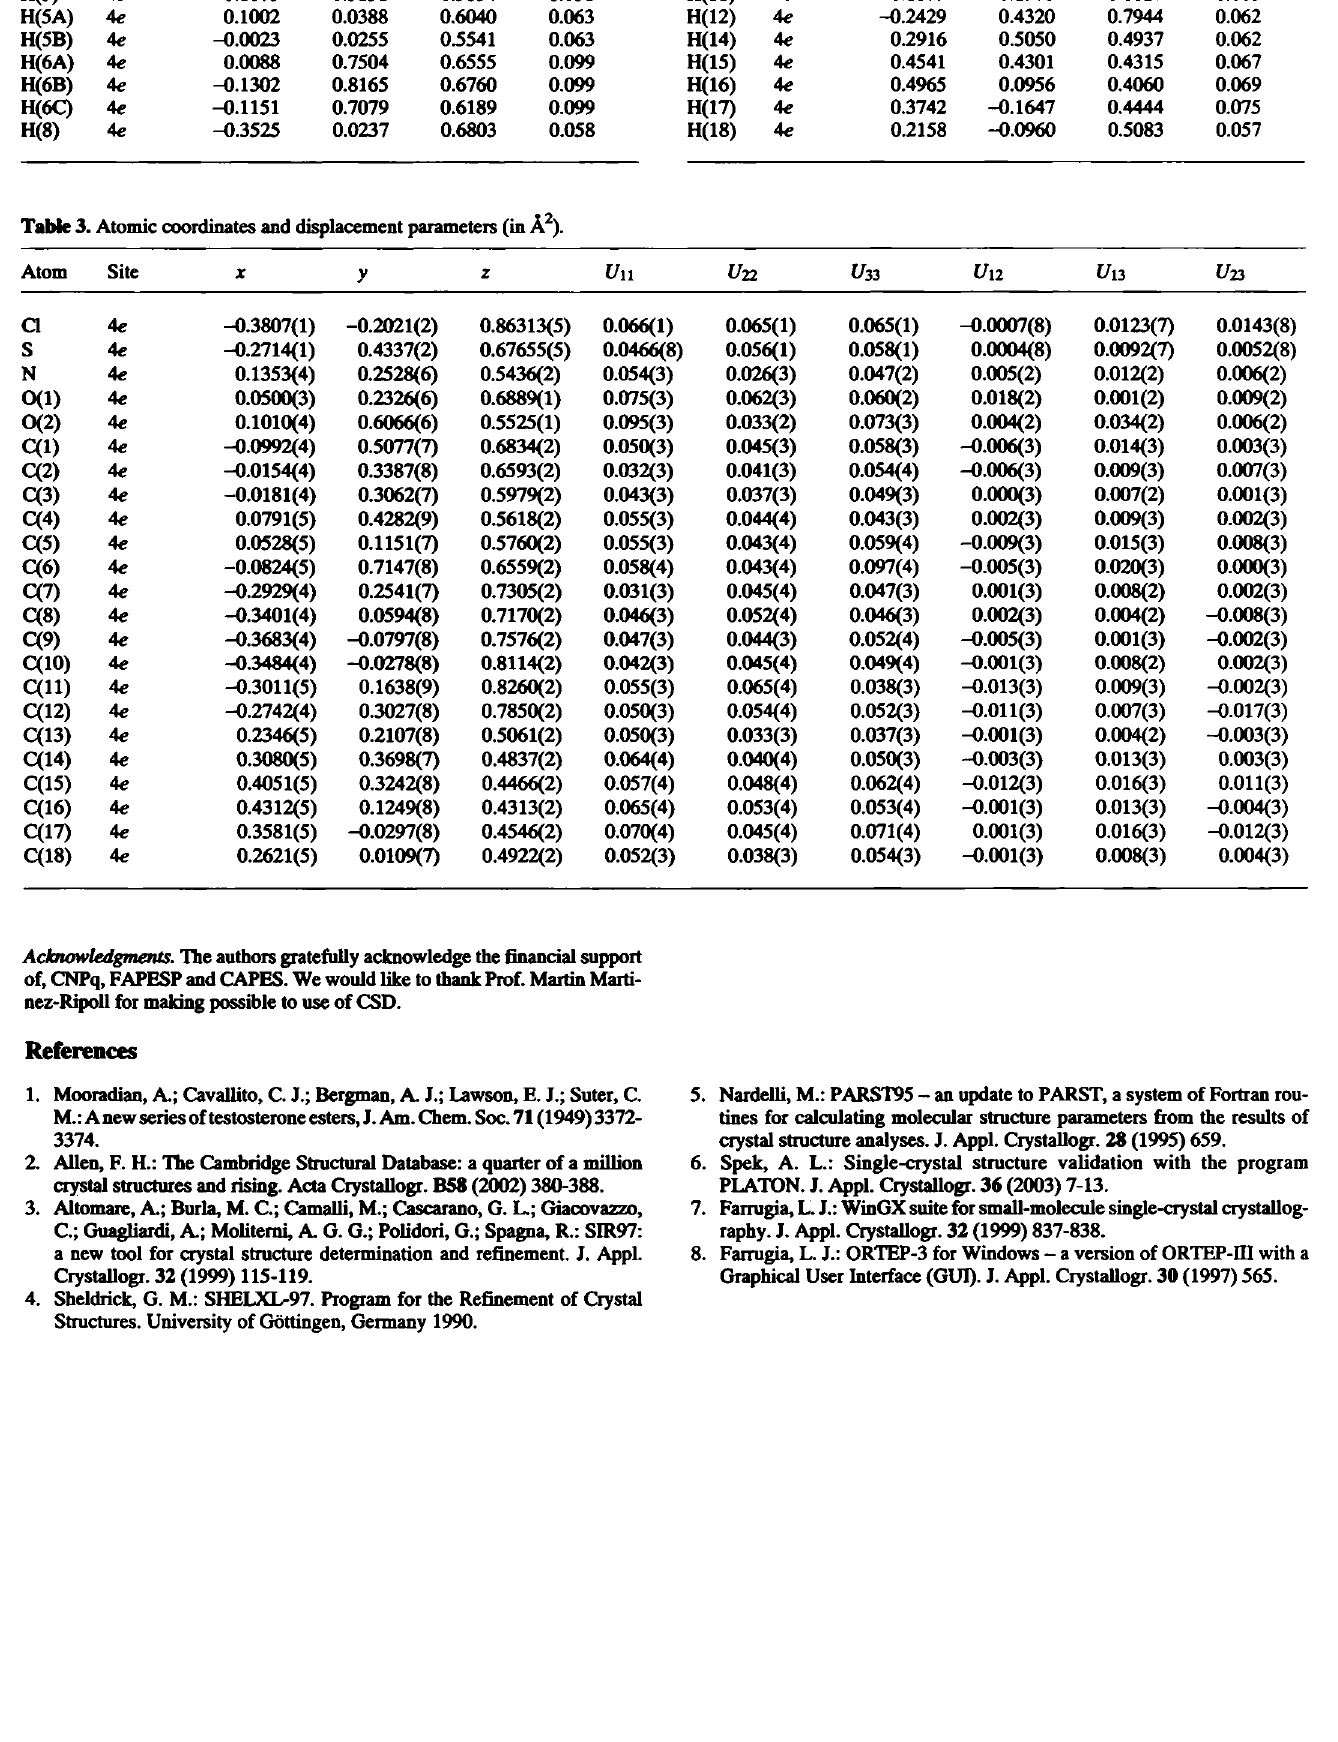
Table 3. Atomic coordinates and displacement parameters (in A 2